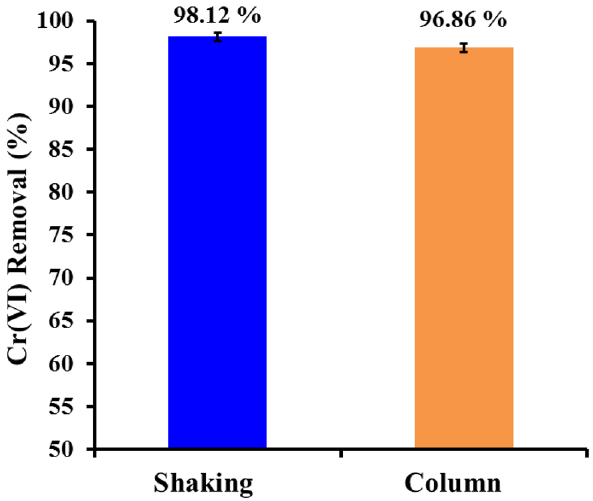
Figure 6. Efficiency of the nWTRs for Cr(VI) removal from wastewater.